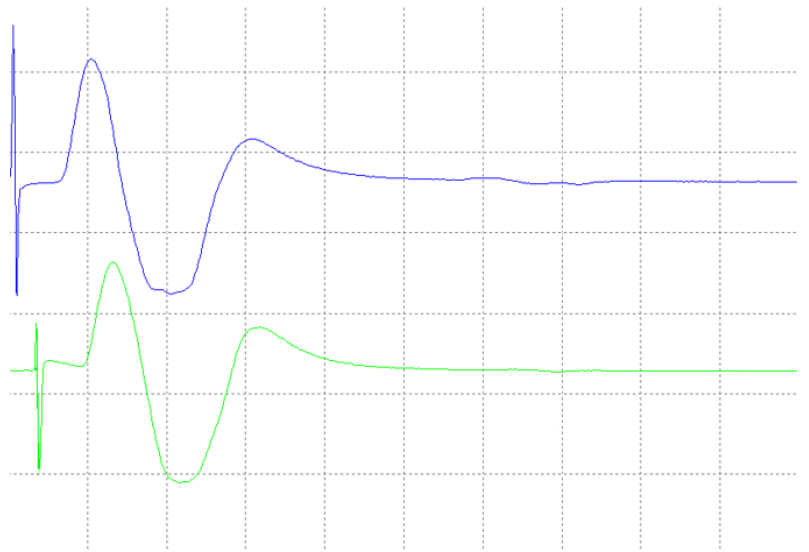
Figure 15. MEP of a healthy volunteer. The blue curve is the one originally obtained from the system. The green curve is obtained with the proposed system. Voltage scale is 5mV/div, time scale is